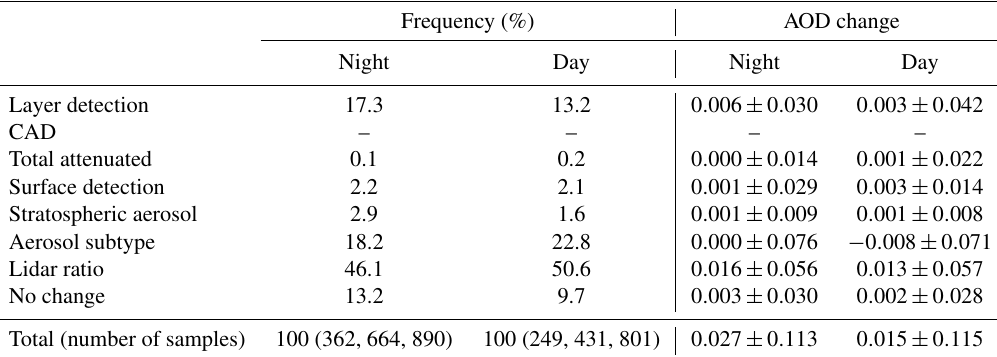
Table 7. Same as Table 6 but for cloud-free sky. Frequency (%) AOD change Night Layer detection CAD – – – – Total